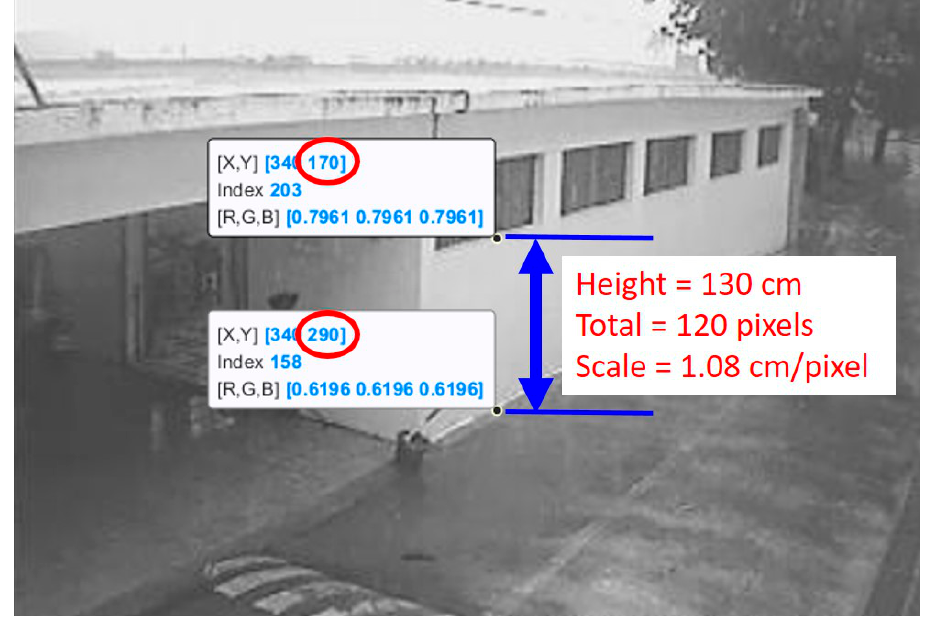
Figure 6. Image scale calculation from CCTV image.